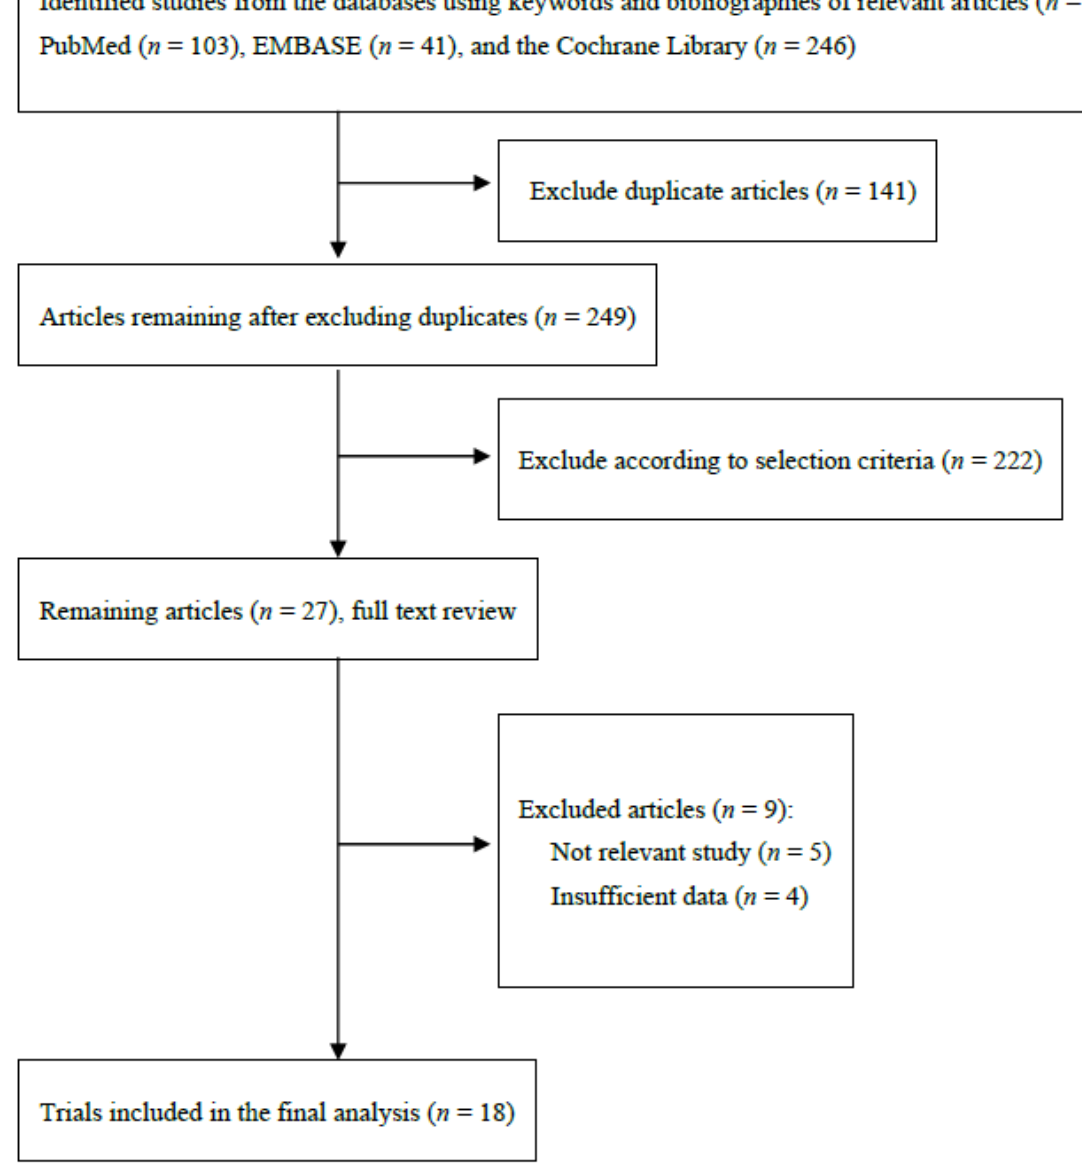
Figure 1. Flow diagram for identification of relevant clinical trials.